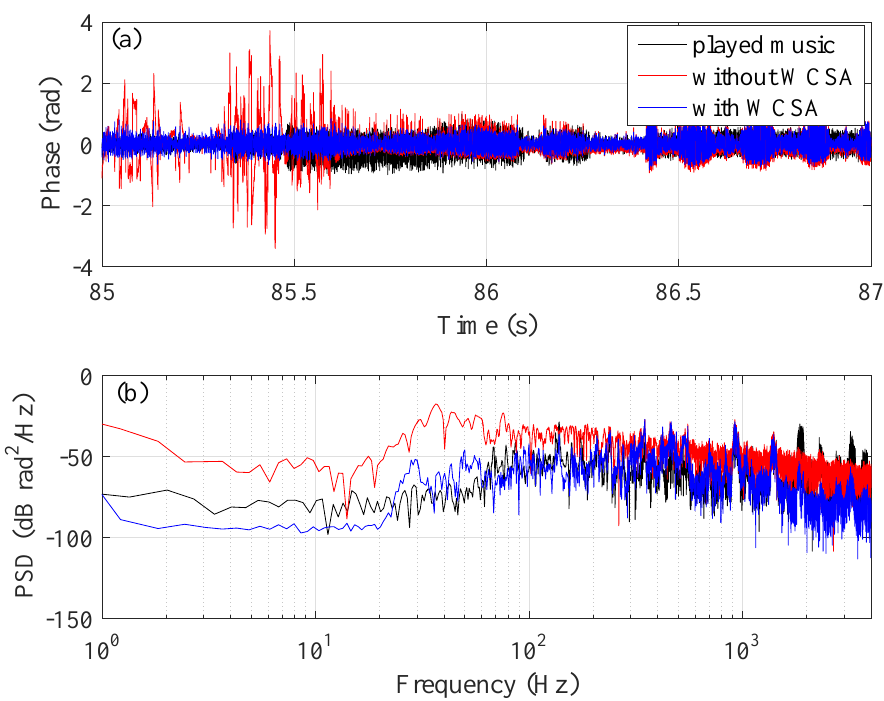
Figure 14. Comparison of the retrieved sound signals without (red) and with (blue) WCSA applied. The black curve is the original music data. ( a ) time-domain signals; ( b ) the PSD of the